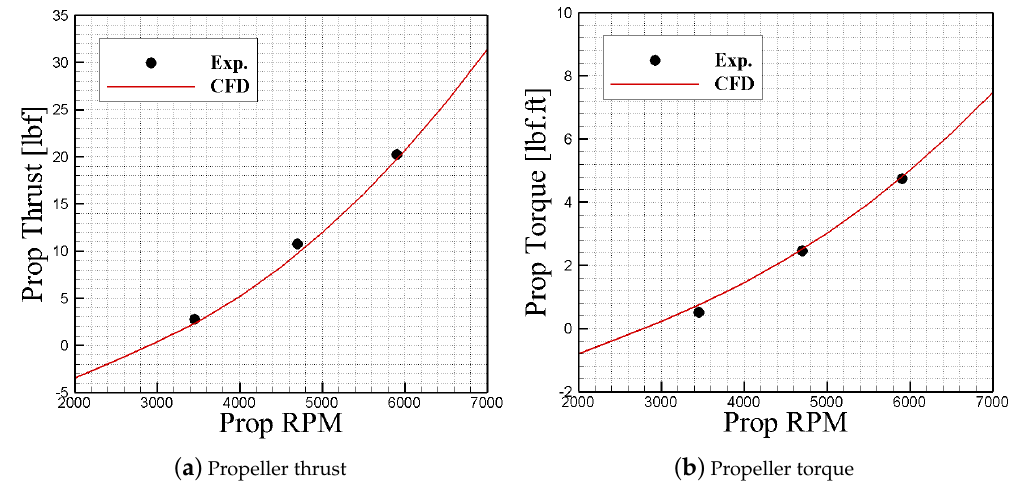
Figure 6. Validation of predicted propeller thrust and torque with experimental